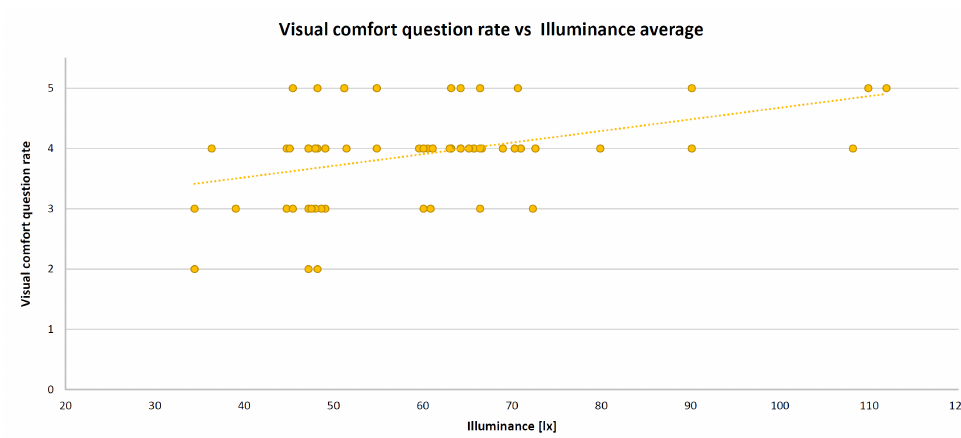
Figure 13. IAQ comfort XY scatter plot and trend line.